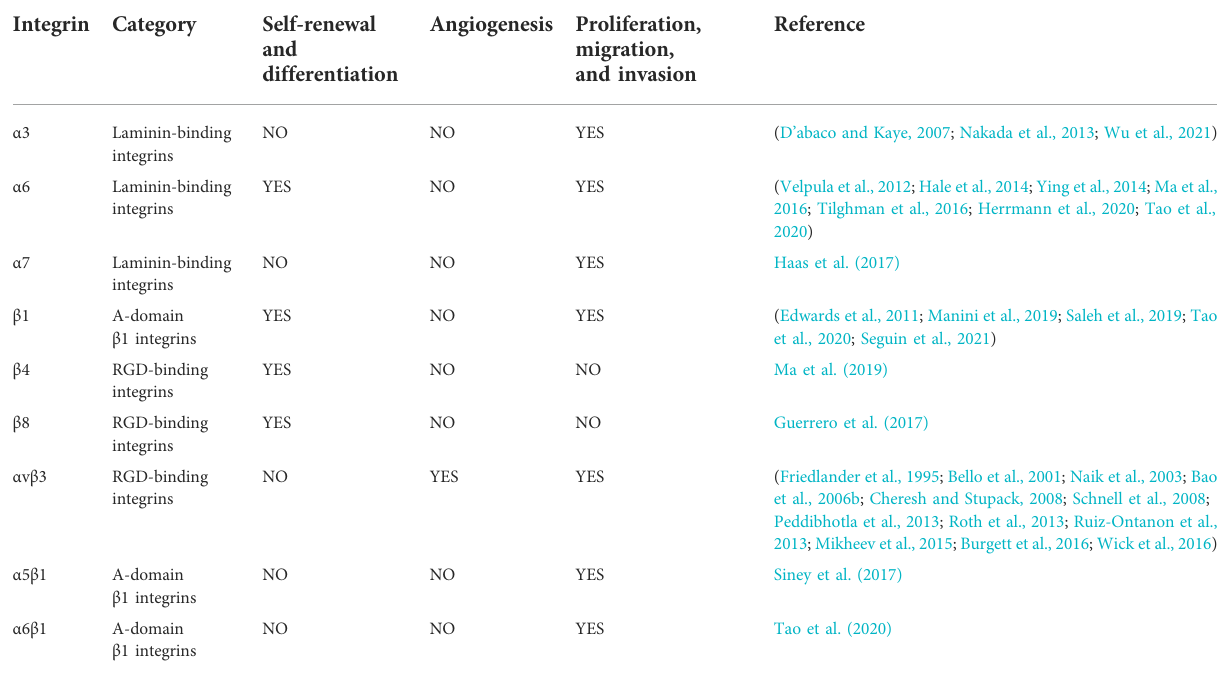
Angiogenesis Proliferation, and migration, differentiation and invasion